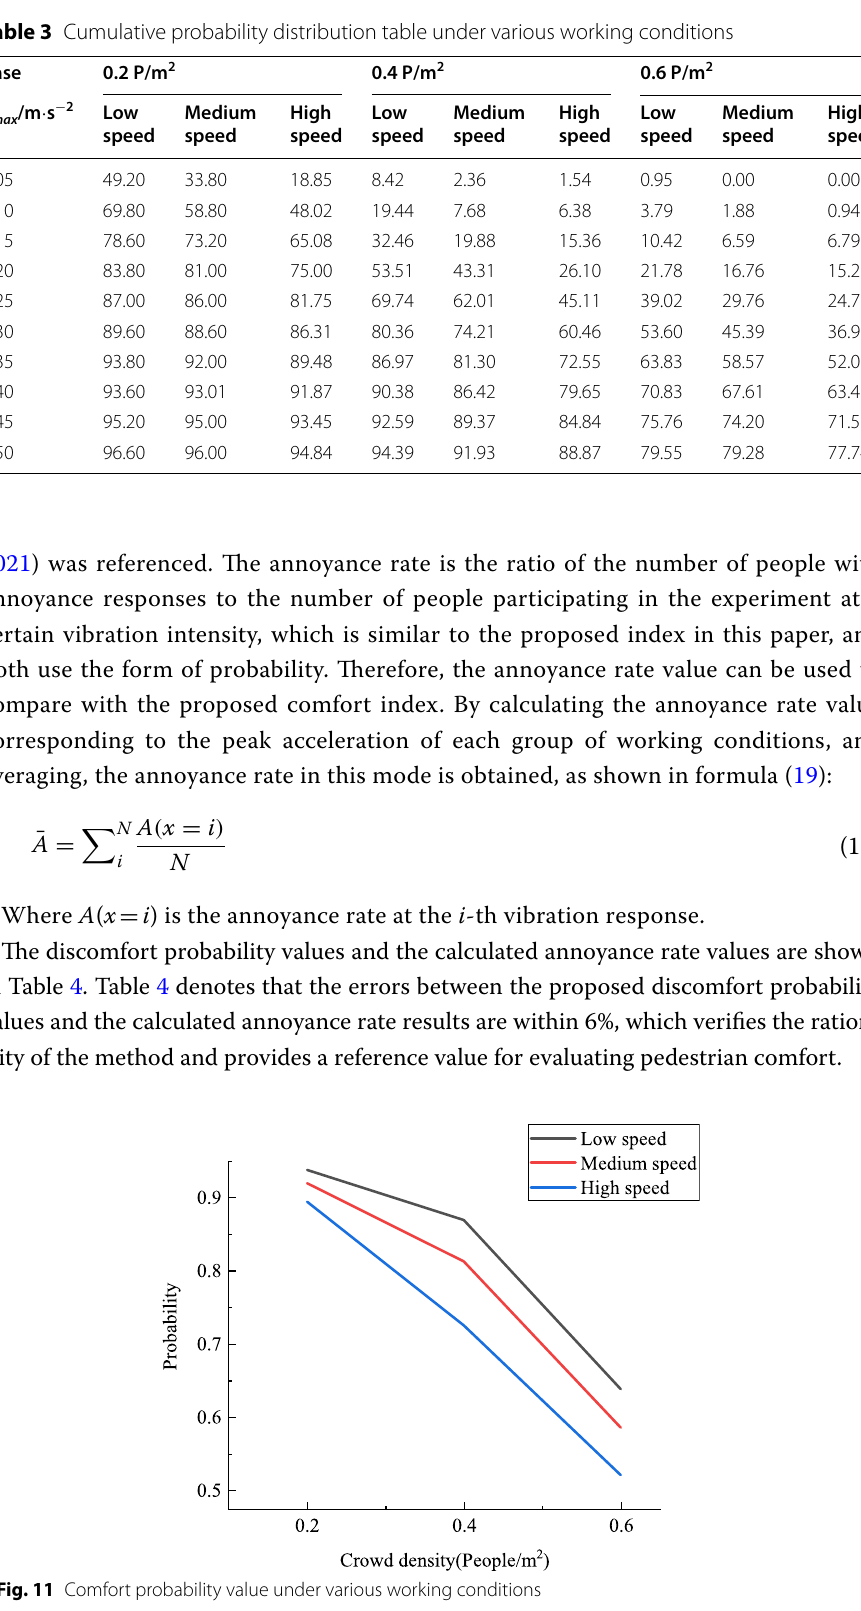
Fig. 11 Comfort probability value under various working